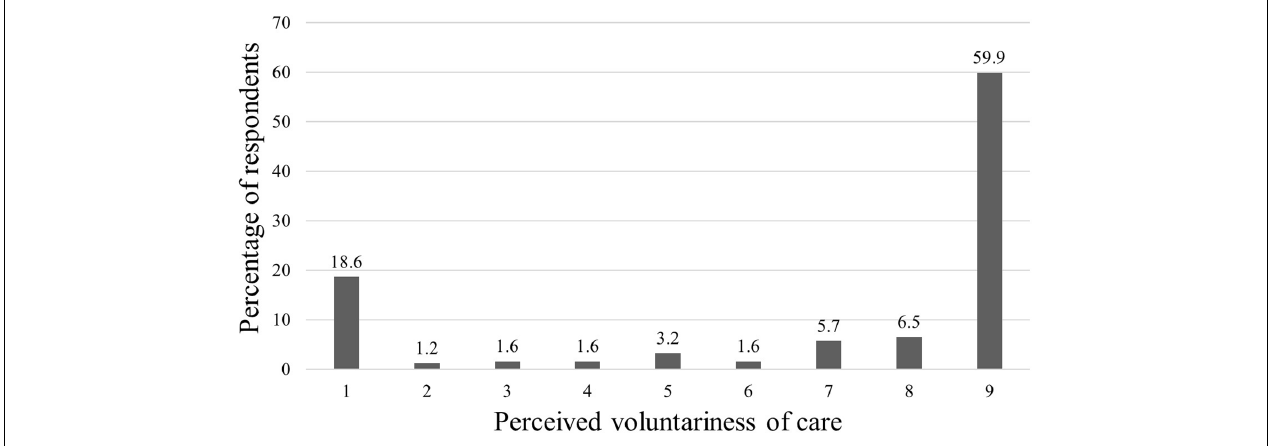
FIGURE 1 | Distribution of responses on the perceived voluntariness of care scale at baseline.